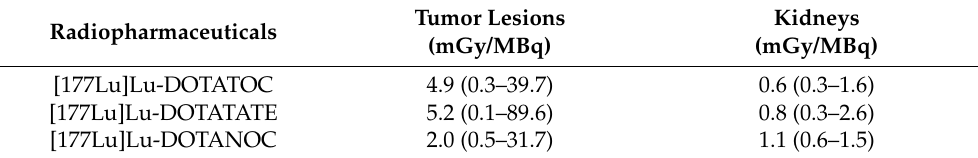
Table 3. Absorbed dose (median and range of variation) for kidney and tumor lesions